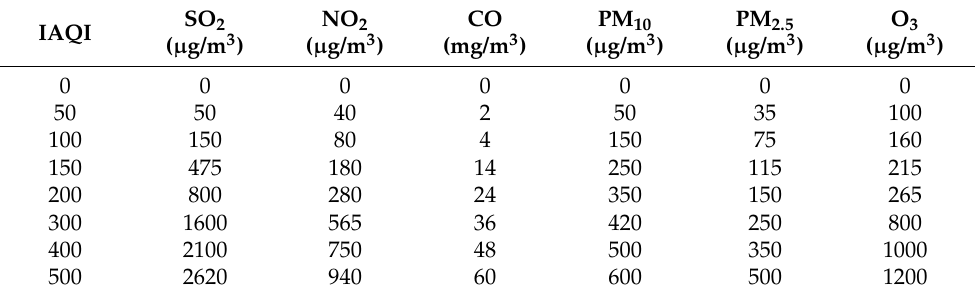
Table 3. Individual air quality index (IAQI) and corresponding concentration limit of pollution items (HJ633-2012). SO 2 NO 2 CO PM 10 PM 2.5 IAQI ( µ g/m 3 ) ( µ g/m 3 ) (mg/m 3 ) ( µ g/m 3 ) ( µ g/m 3